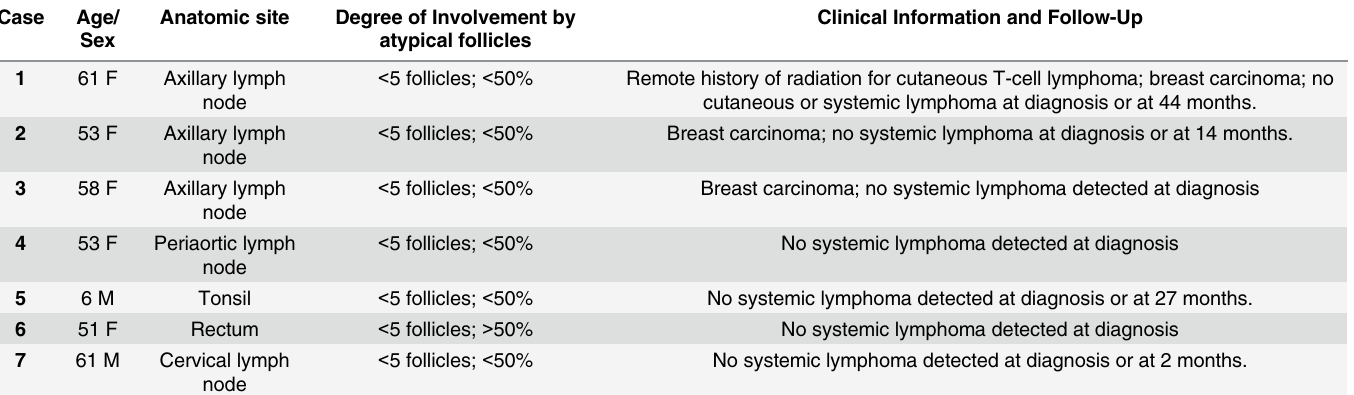
Table 2. Summary of Clinical and Histologic